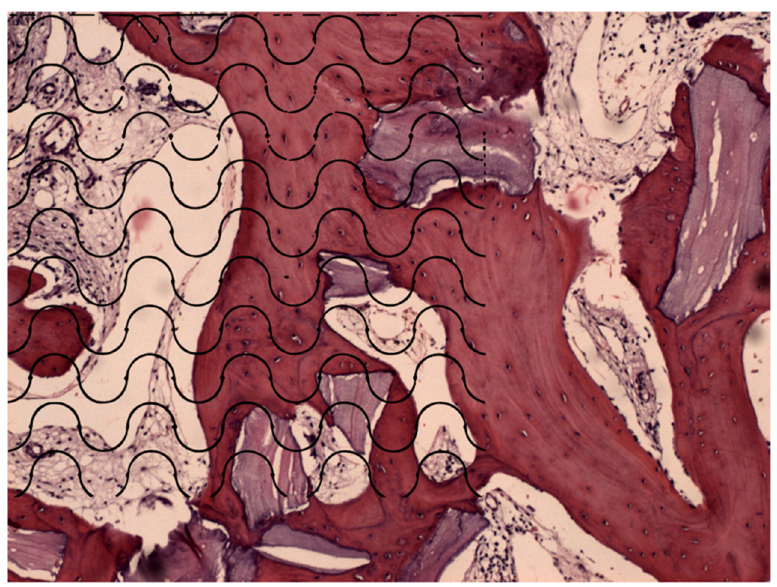
Figure 1. Histological section photography with the grid of Merz attached. Each point represents 1% of the tissue evaluated.